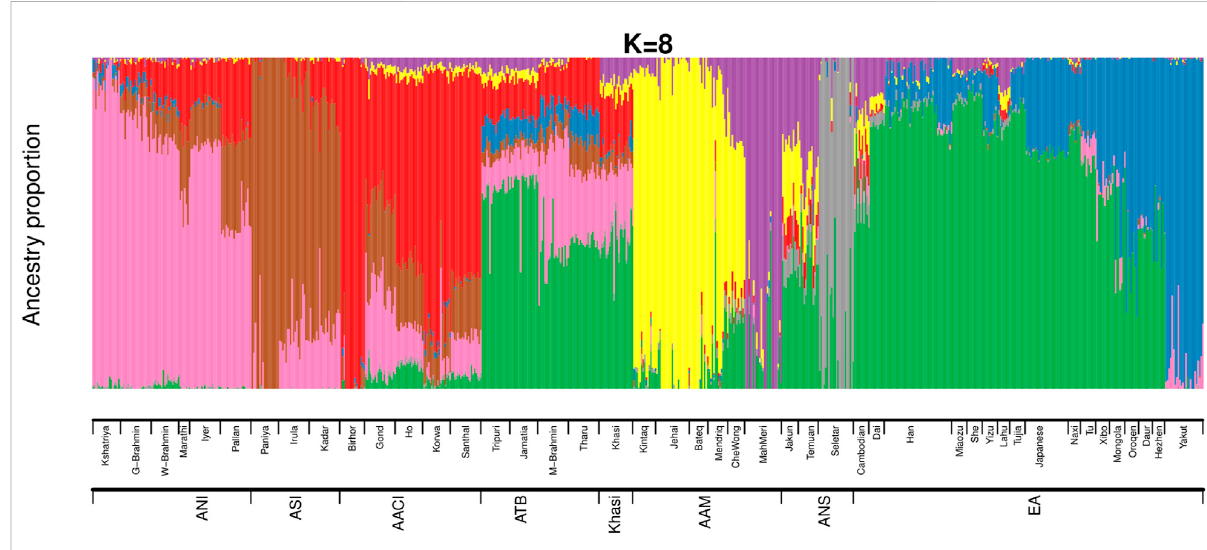
FIGURE 2 ADMIXTURE analysis on Mainland Indian populations, Malaysians and East Asians of HGDP (ANI: Ancestral North Indian, ASI: Ancestral South Indian, AACI: Austroasiatics of Central India, ATB: Ancestral Tibeto Burman, AAM: Austroasiatics of Malaysia, ANS: Austronesians, EA: East Asians of